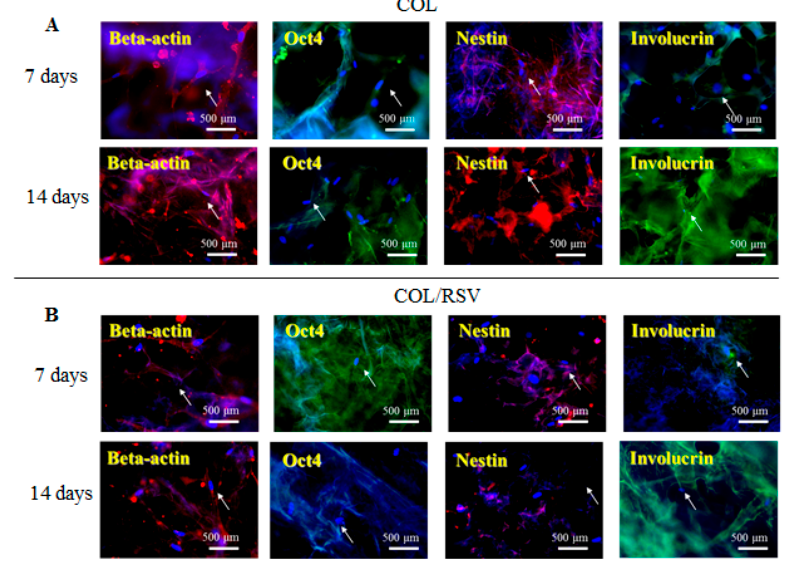
Figure 7. Representative images showing COL and COL / RSV biocompatibility with hASCs. ( A ) COL and ( B ) COL / RSV sca ff olds immunostained with the stem cell biomarkers OCT4, nestin, and the keratinocyte-di ff erentiation marker involucrin. β -actin was used as an internal staining control. White arrows indicate positive antibody expression in the sca ff old. Nuclei were counterstained with Hoechst 33342 (blue). Scale bar = 500 µ